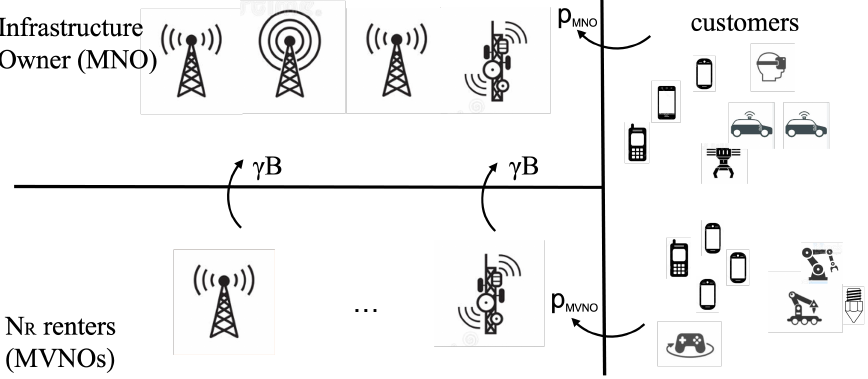
Figure 1. Relationships between customers, the MNO, and